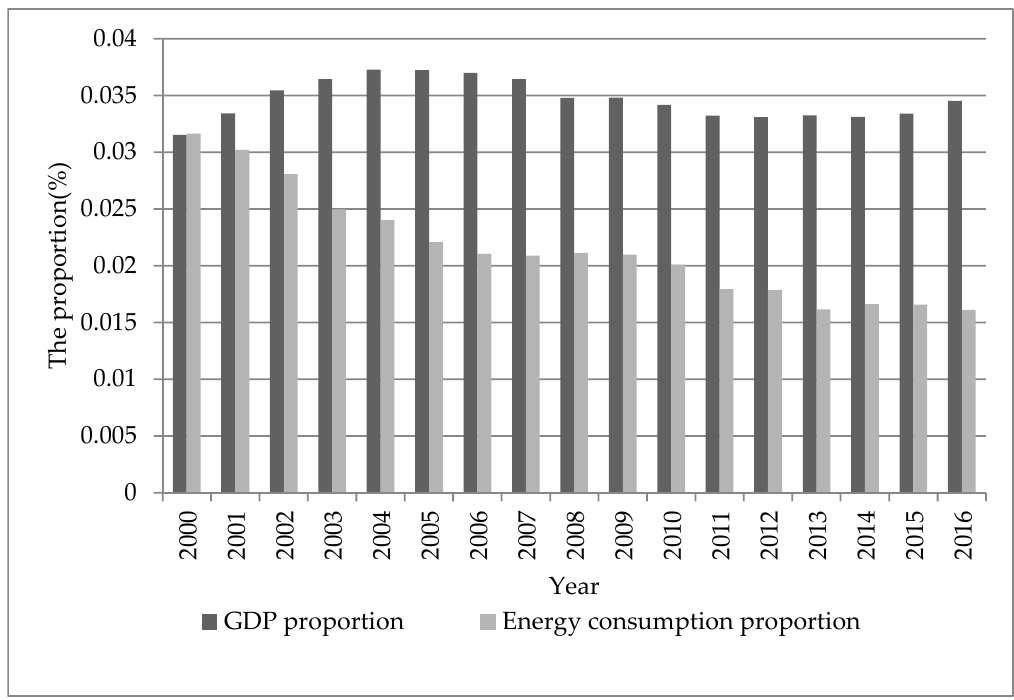
Figure 2. Beijing GDP and energy consumption proportion in China. Source: Elaboration on China Statistics Yearbook (2017).